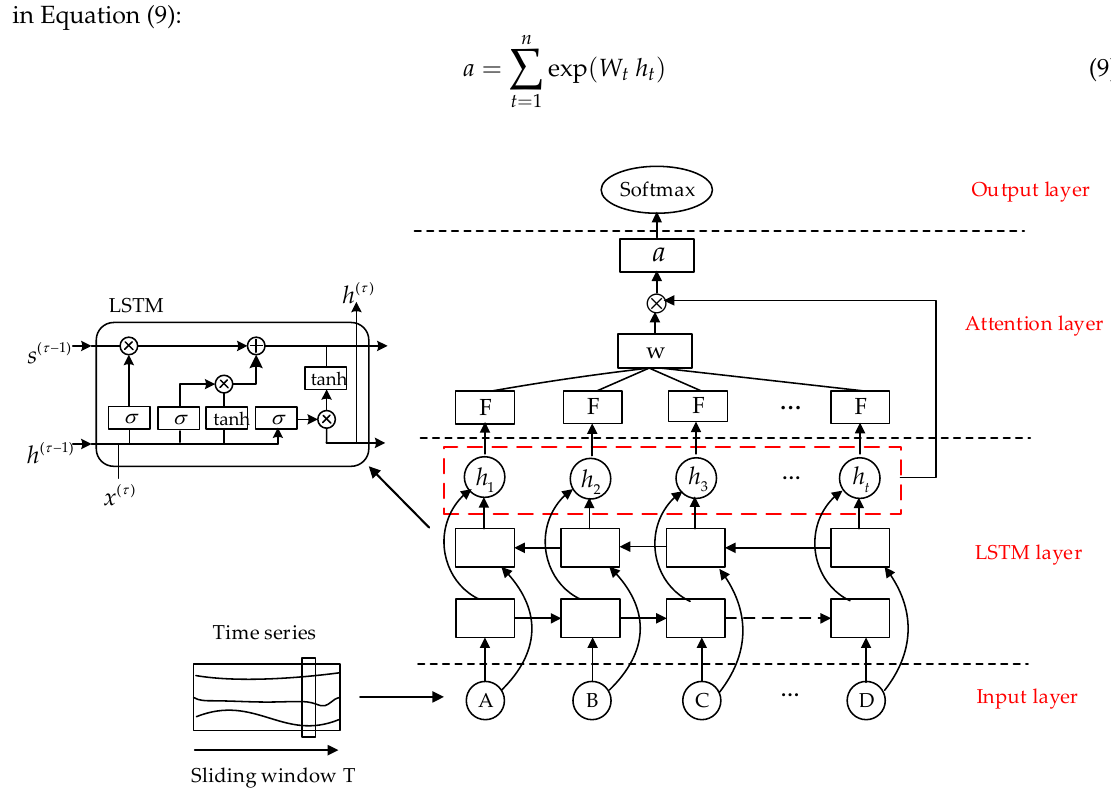
Figure 2. LSTM framework for integrating attention